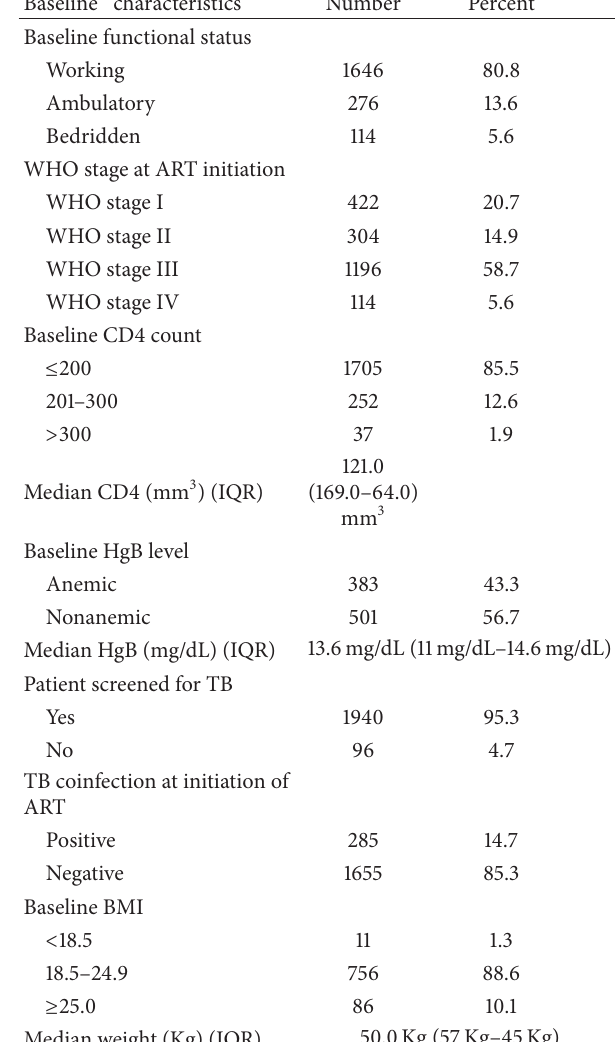
Table 2: Clinical characteristics of ART clients, Goba Hospital, Southeast Ethiopia,